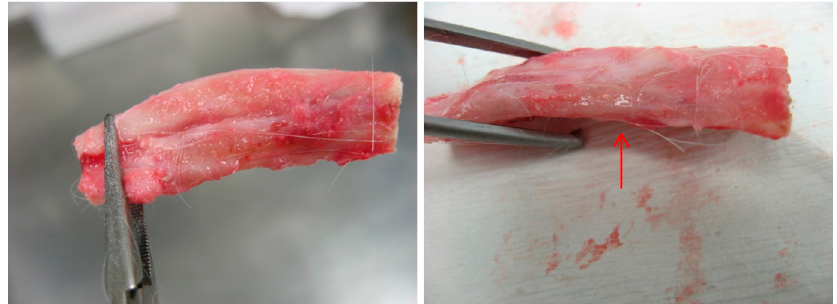
Figure 13. Rabbit fore arm with critical bone defect treated with polyurethane composite filler (PU/PL 2:1) after 6 month’s healing. There is a general restoration of appearance of the original bone. Cartilage-like issue (red arrow) can be found on the implantation.